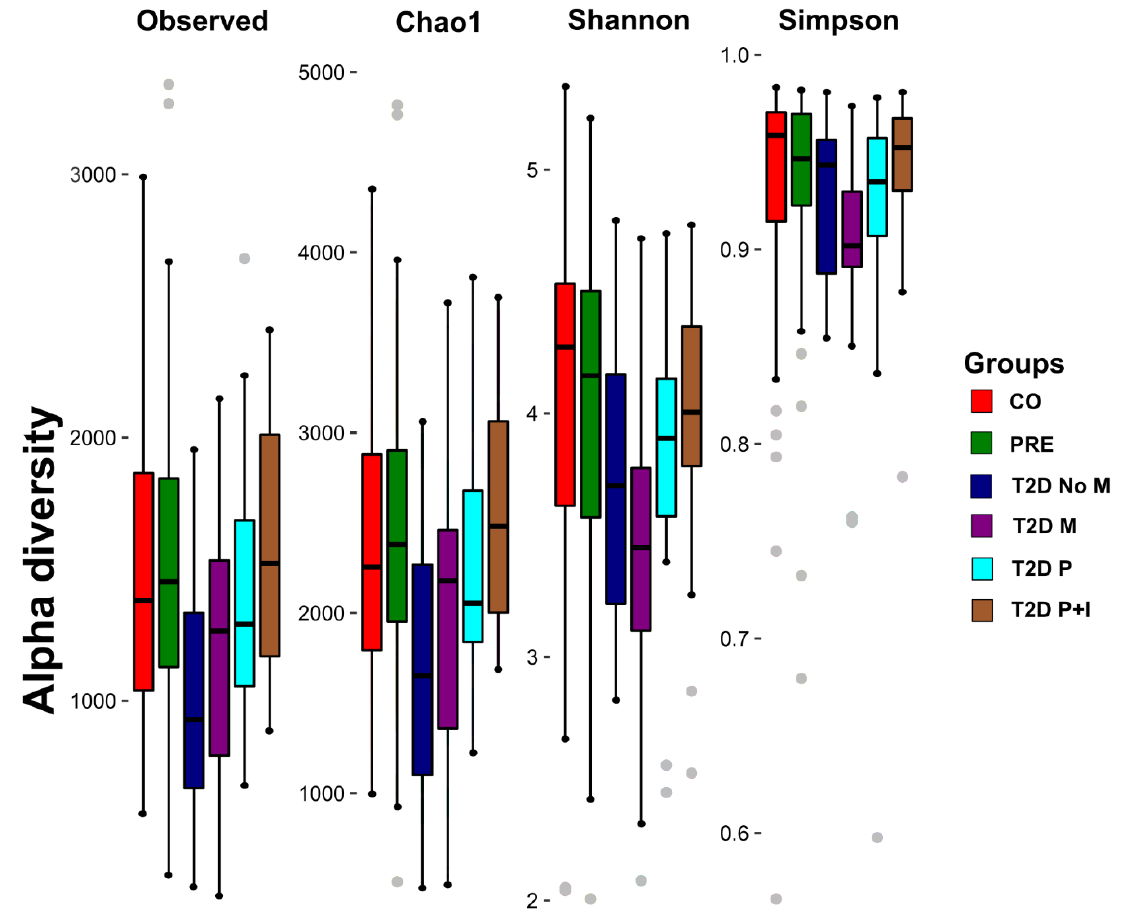
Figure 2. Bacterial alpha diversity. The box-plot figures show the Alpha Diversity of the bacterial communities in the six study groups: Control (CO), Prediabetes (PRE), T2D no medicated (T2D−No−M), T2D with Metformin (T2D−M), T2D with polypharmacy (T2D−P), and T2D with polypharmacy + insulin (T2D−P+I) by means of Observed (number of observed OTUs), Chao1 (richness), and Shannon and Simpson diversity indexes. Plotted in the graphics are the interquartile ranges (bottom and top of boxes), medians (middle lines in the boxes), and the lowest and highest values for the first and third quartiles. Dots represents outlier individuals, and each group is identified by colors as indicated on the legend at the right side of the figure (see Table